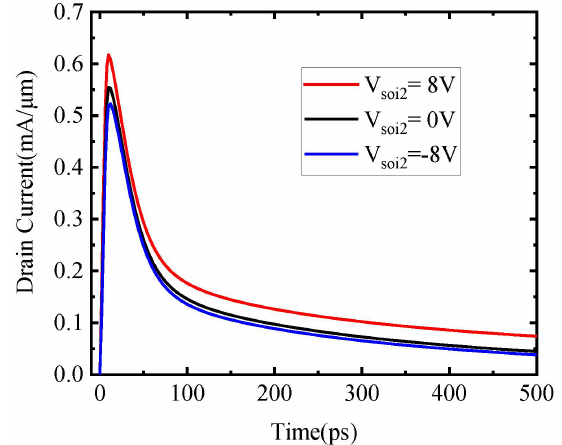
Figure 10. SET current with different back-gate biased conditions in TCAD simulation